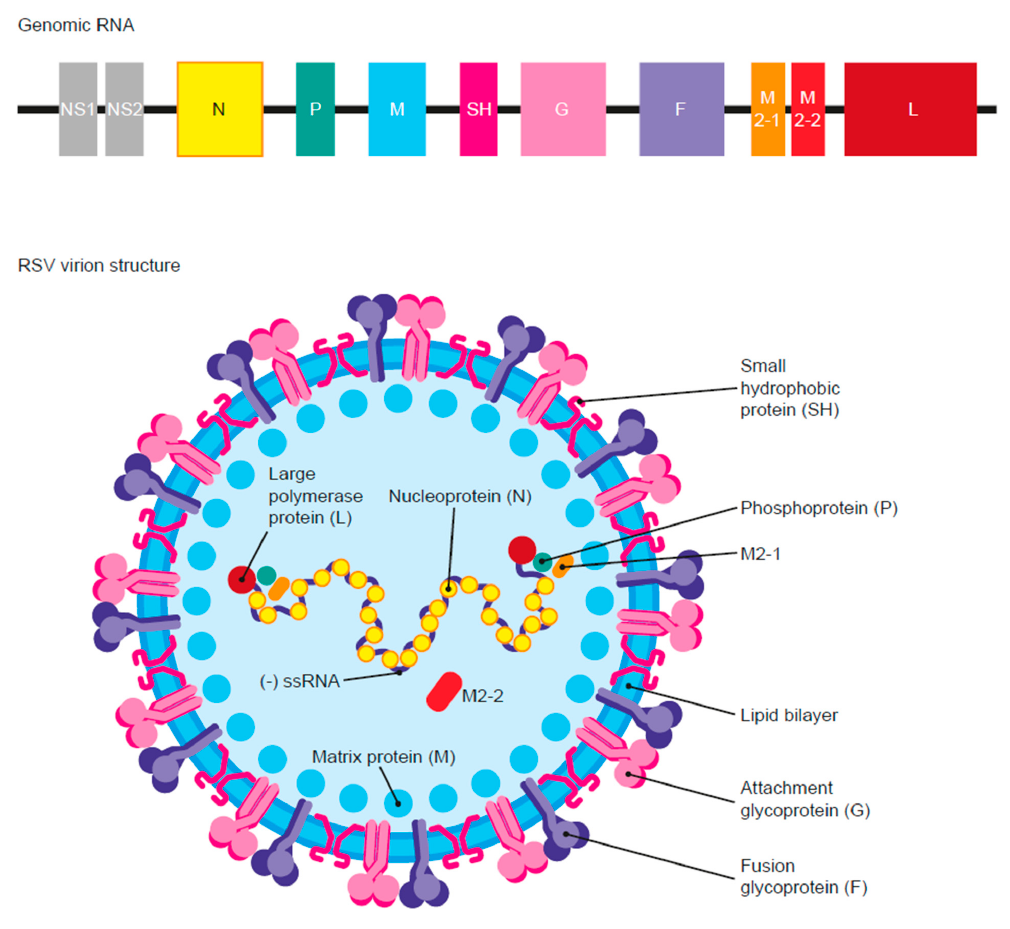
Figure 1. Respiratory syncytial virus (RSV) genome and virion structure. RSV is a negative-sense, single-stranded RNA virus encoding 11 proteins: nine structural and two non-structural proteins. The fusion glycoprotein (F), attachment glycoprotein (G), and the small hydrophobic protein (SH) are transmembrane proteins comprising the viral envelope. Matrix proteins (M) are found at the inner side of the viral envelope. Four nucleocapsid and regulatory proteins function as viral